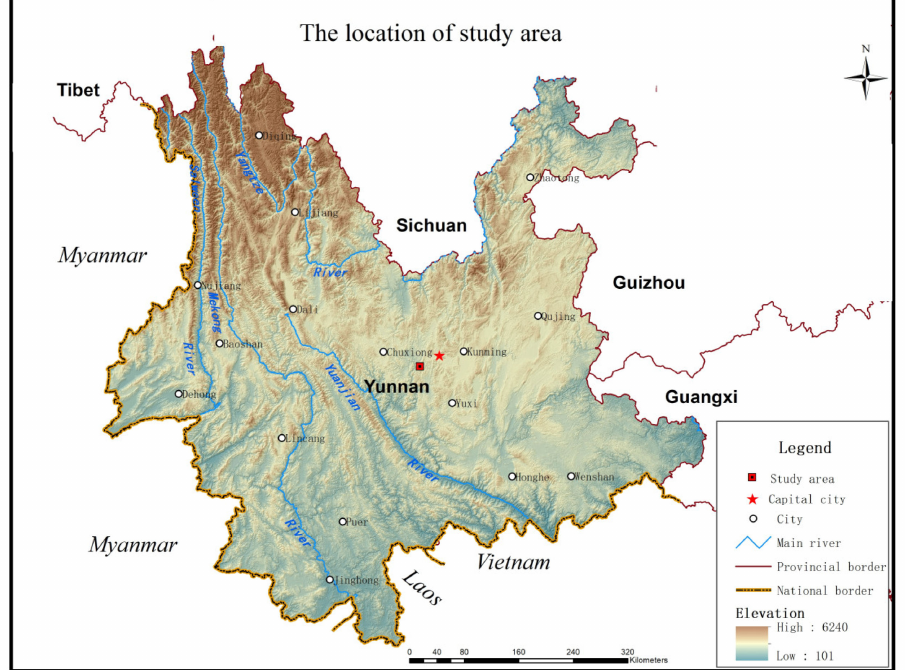
Figure 1. Location of the study